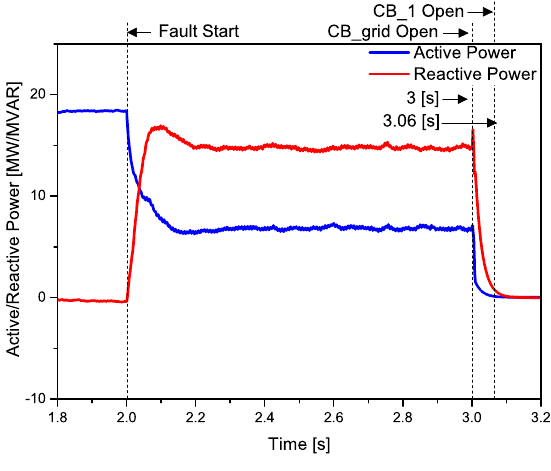
Figure 12. Offshore wind farm output with an